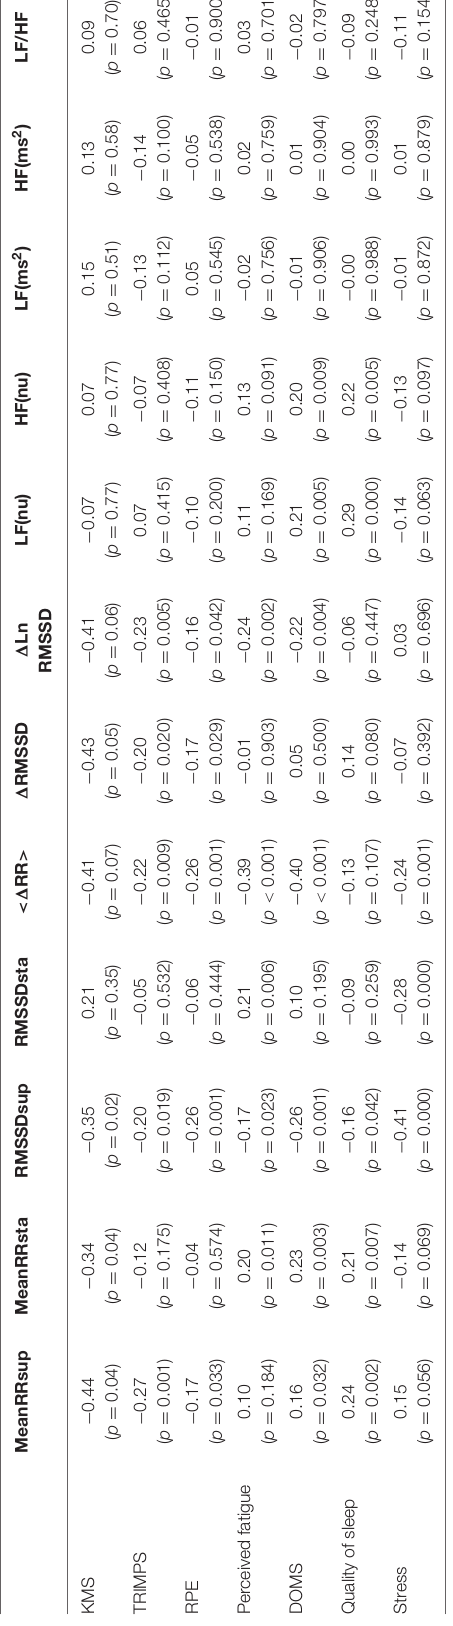
(cid:49) RR and the (cid:49) LnRMSSD observed. To further quantify